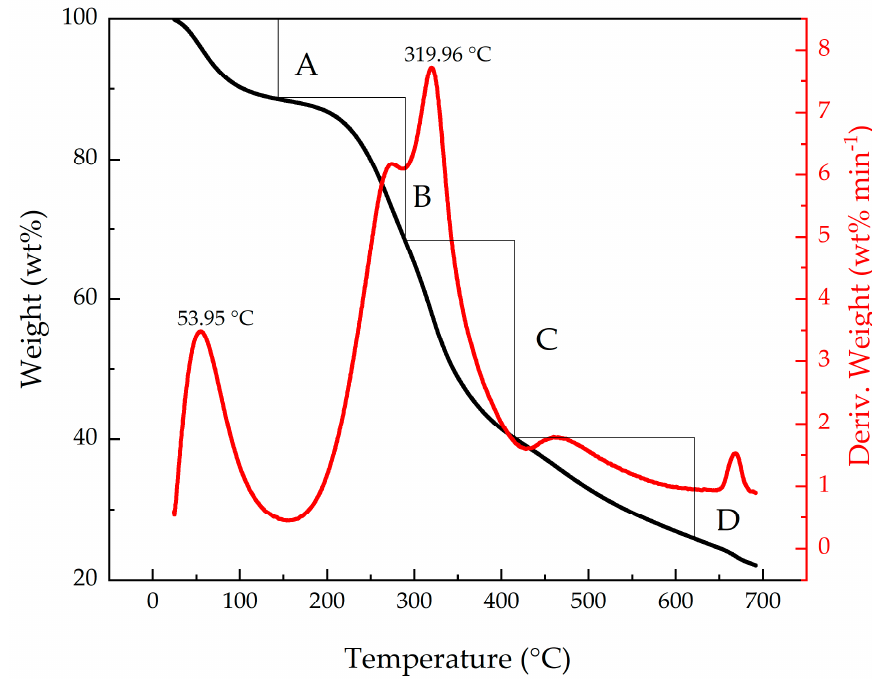
Figure 4. Thermal Decomposition Curve of the corrosion inhibitor produced from the Artemisia vulgaris . Table 2. Mass loss